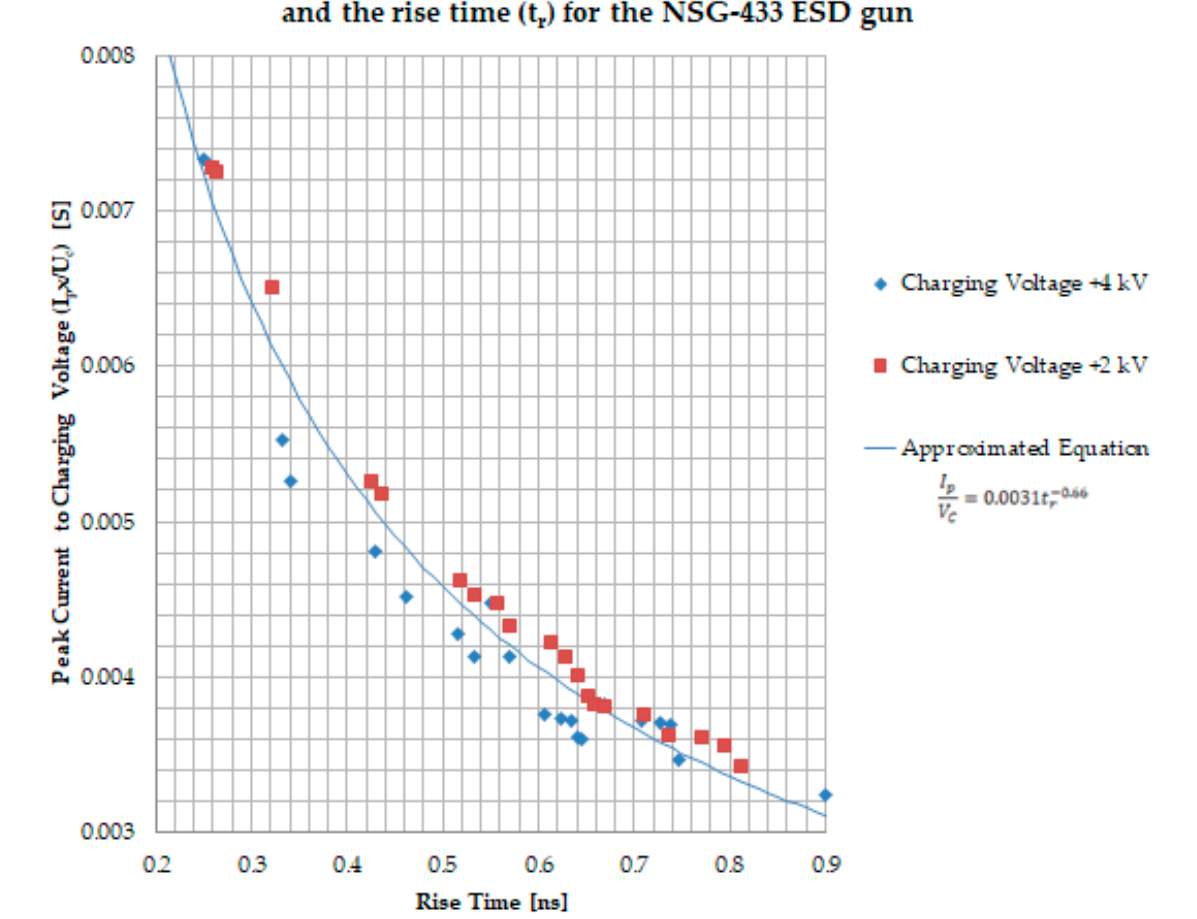
Figure 8. Relationship between the peak current to charging voltage ( I p / U c ) and the rise time ( t r ) for the NSG-433 ESD gun.